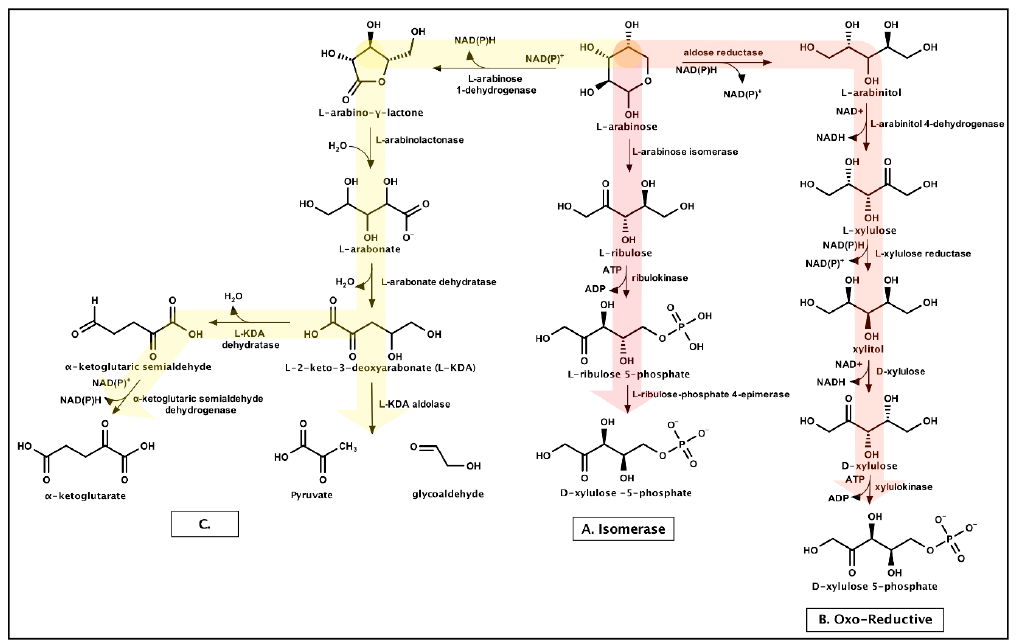
Figure 4. Arabinose catabolic pathways. The (A) isomerase and (B) oxo-reductive pathways generate xylulose-5-phosphate for the pentose phosphate pathway. The (C) oxidative type pathway generates the TCA intermediate, α -ketoglutarate, or the central carbon metabolites, pyruvate and